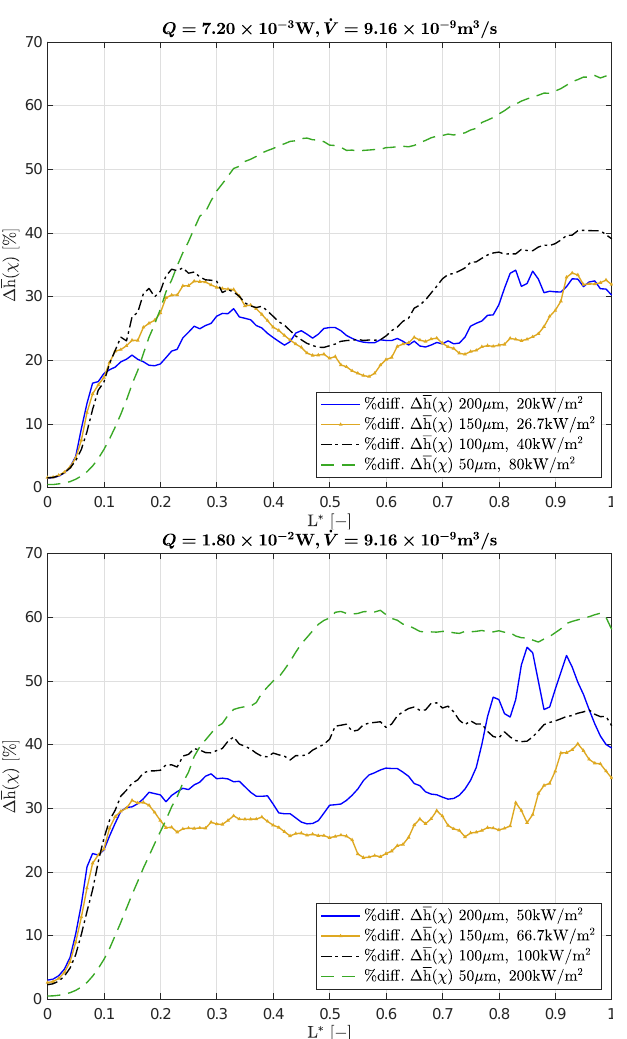
Figure 5. Effect of hydraulic diameter on time-averaged heat transfer coefficient difference ∆ h ( x ) over the dimensionless length L* between the corresponding single and two-phase simulations for the examined hydraulic diameters with constant heat transfer and volumetric flow rate and varying heat and mass fluxes. Table 5. Comparison of the 𝑁𝑢 𝑔𝑙𝑜𝑏 and percentage difference between single-phase and two-phase results for the exam- ined 𝑄 and D h .